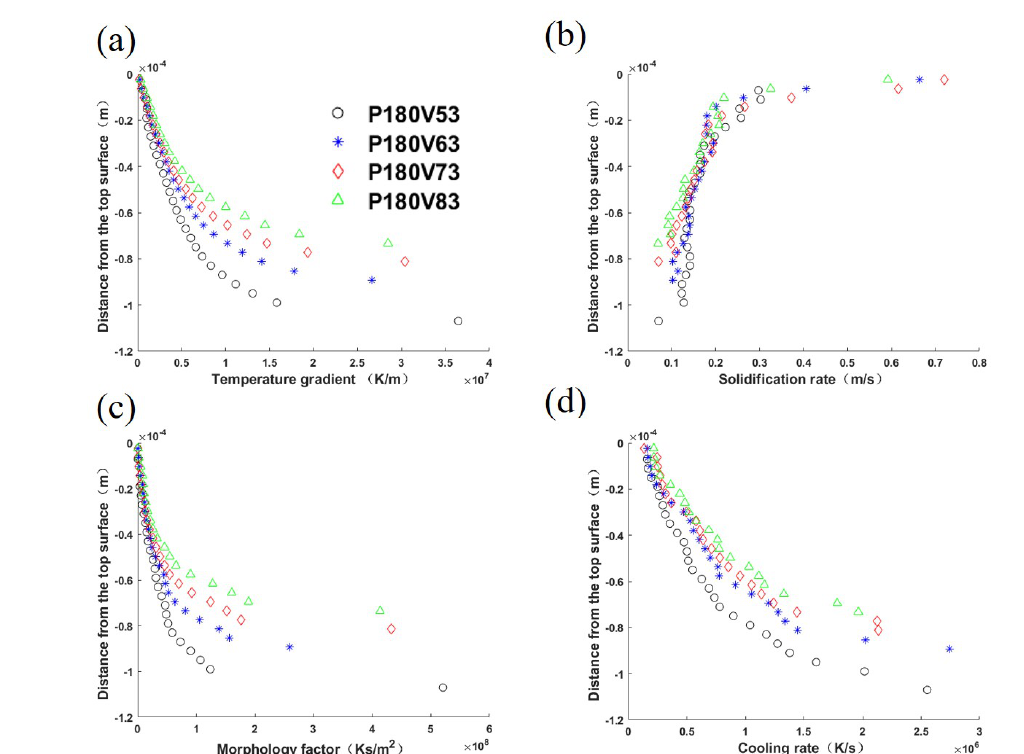
Figure 13. Solidification parameters of the longitudinal section of the melt pool center: ( a ) temperature gradient magnitude G , ( b ) solidification rate R , ( c ) morphology factor M = G / R , and ( d ) cooling rate C = G · R , for cases with laser scan speed vary within the range of [0.53 m/s, 0.83 m/s], and the constant laser power of 180 W. The abscissa represents the distance from the top surface of the melt pool.